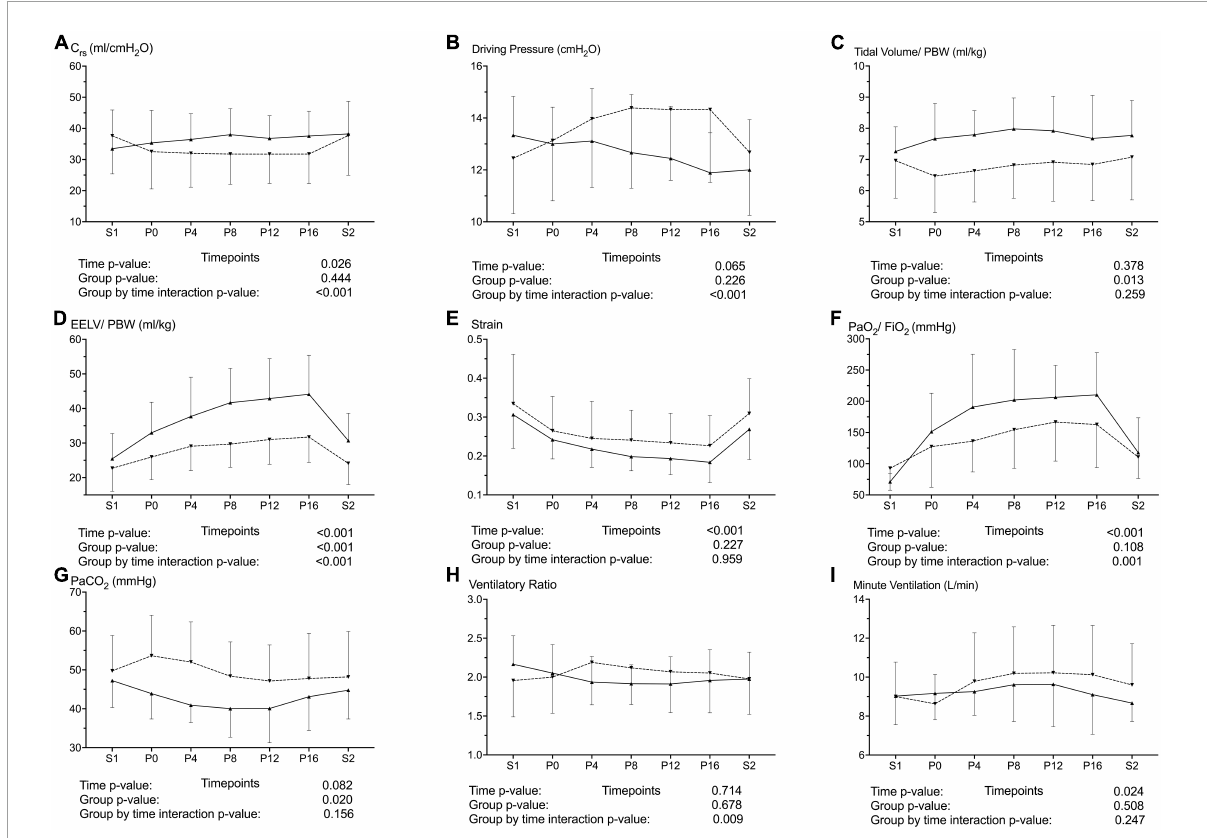
FIGURE4 Changes in the resting lung volume, respiratory mechanics and gas exchange during the study time line and after stratification by the change in the respiratory system compliance (C rs ) during prone position (PP) in COVID-19 ARDS patients. Upward triangles with solid lines represent increased C rs during PP (responders, n = 9) and downward triangles with dashed lines represent Decreased or Equal C rs during PP (non-responders, n = 31). P -values from the 2-way ANOVA for repeated measurements are provided below each variable. Data are presented as mean and unidirectional error bar. S1: supine position at baseline, 15 min after mechanical ventilation adjustments; P0, P4, P8, P12, P16: 15 min, 4, 8, 12 and 16 h of prone positioning; S2: 15 min after turning back to the supine position following a 16-h PP cycle. Upper Panel: Respiratory system compliance (A) , Driving Pressure (B) , tidal volume/Predicted body weight (PBW) (C) . Mid Panel: end-expiratory lung volume/Predicted body weight (EELV/PBW) (D) , Strain (E) , PaO 2 /FiO 2 (F) . Lower Panel: Partial pressure of arterial carbon dioxide (PaCO 2 ) (G) , Ventilatory Ratio (H)